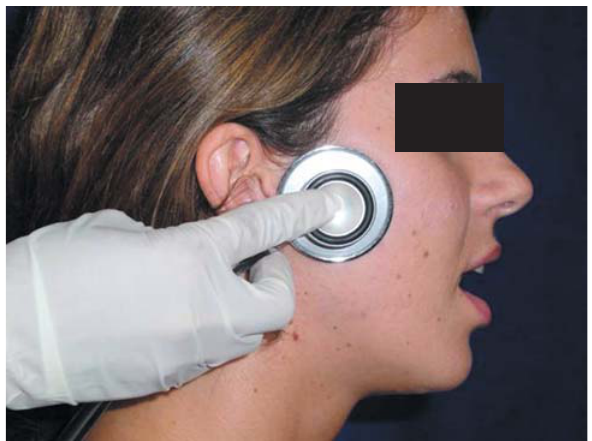
FIGURE 2- Joint sound inspection with a stethoscope